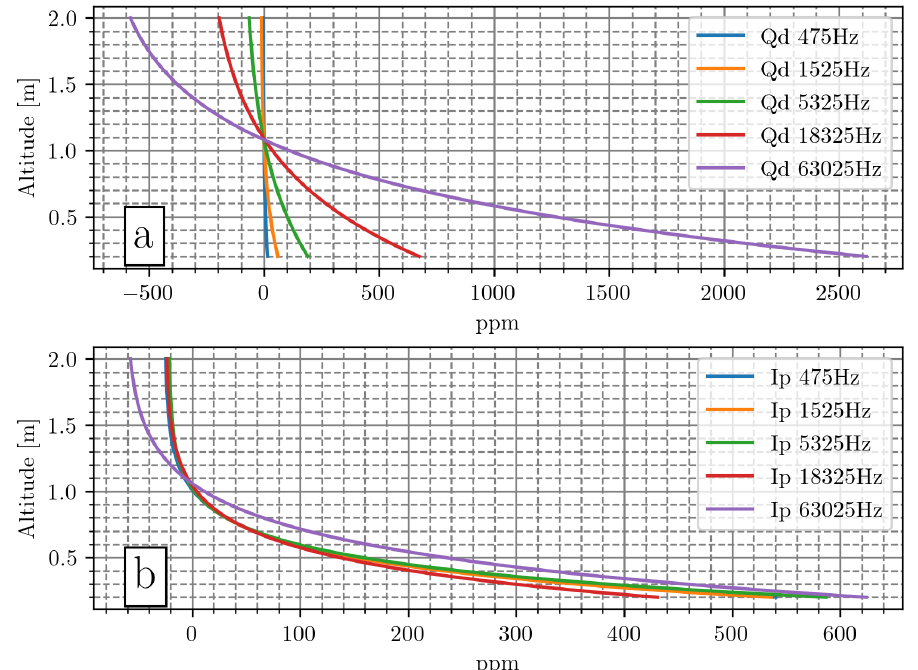
Figure 11. Calculated fits of parts-per-million values vs. altitude for all frequencies of the Falster survey. The parameters a , b , and c are optimised to the smallest least-squares misfit for the equations a + b · exp (h · c) , where h is the altitude. All parameters are listed in Table